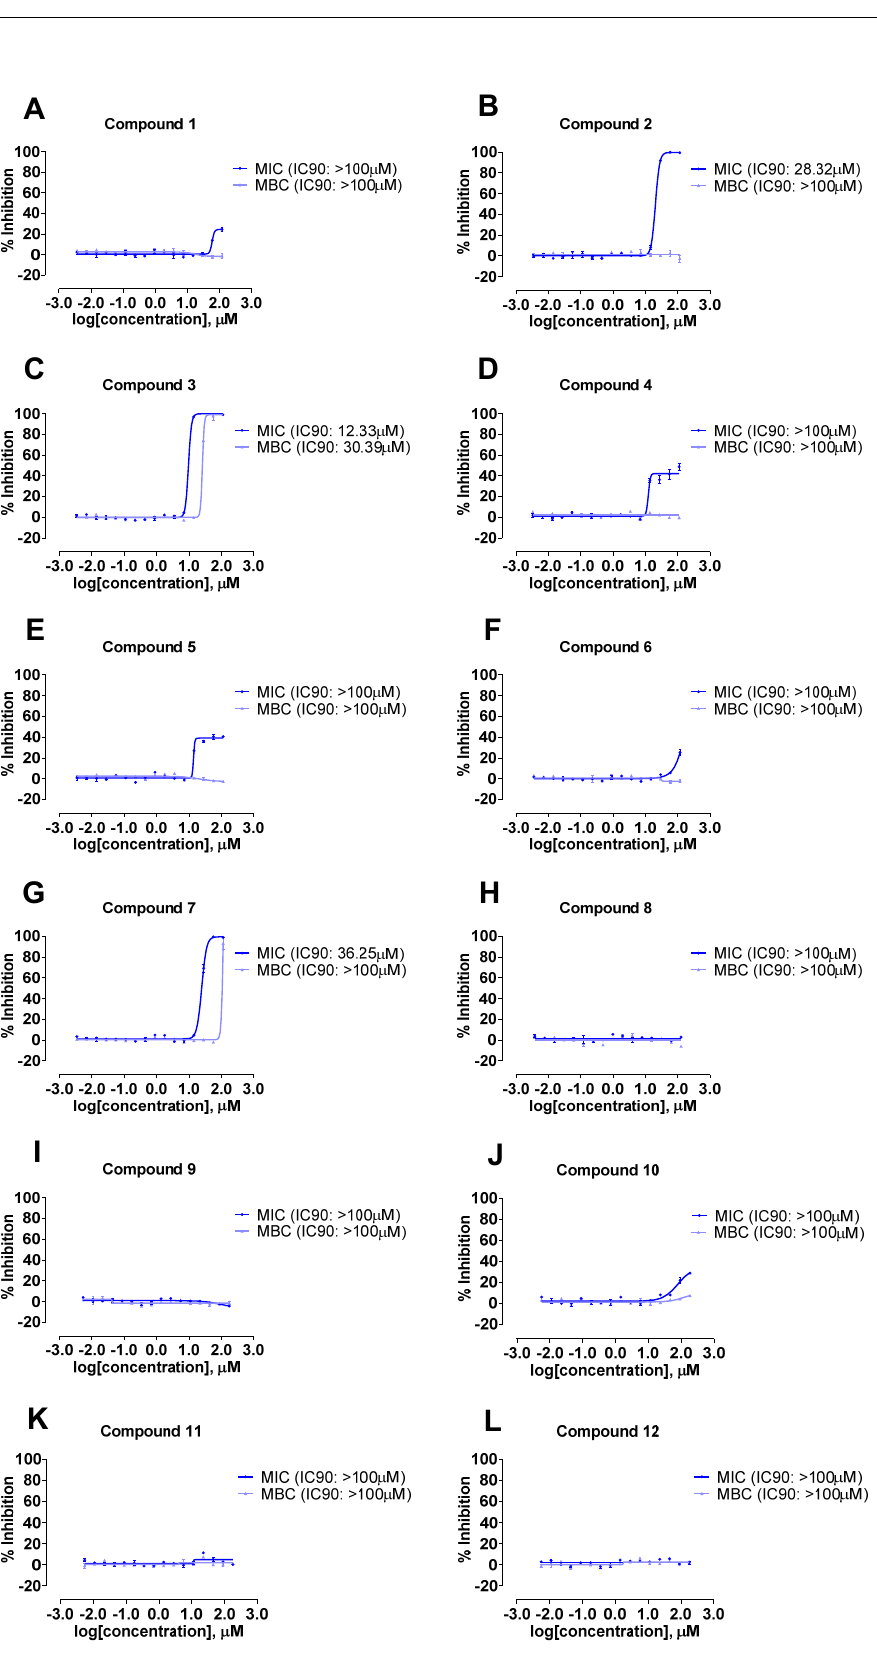
Figure 10. Inhibitory effect dose–response curve against A. baumannii (ATCC ® 19606) for compounds 1 – 12 ( A – L ).